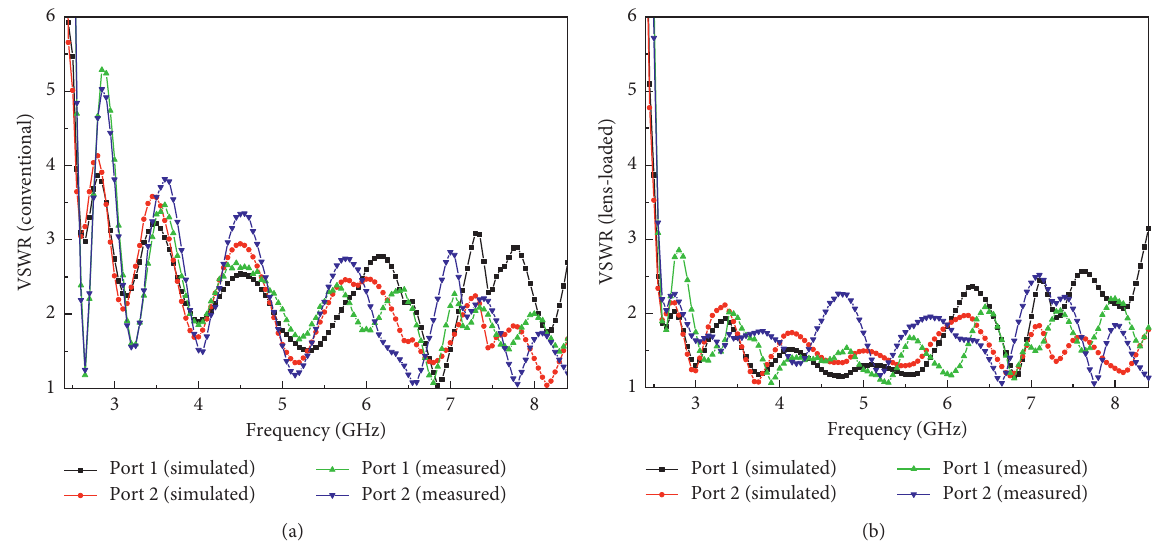
Figure 4: The simulated and measured VSWR data of (a) conventional and (b) lens-loaded